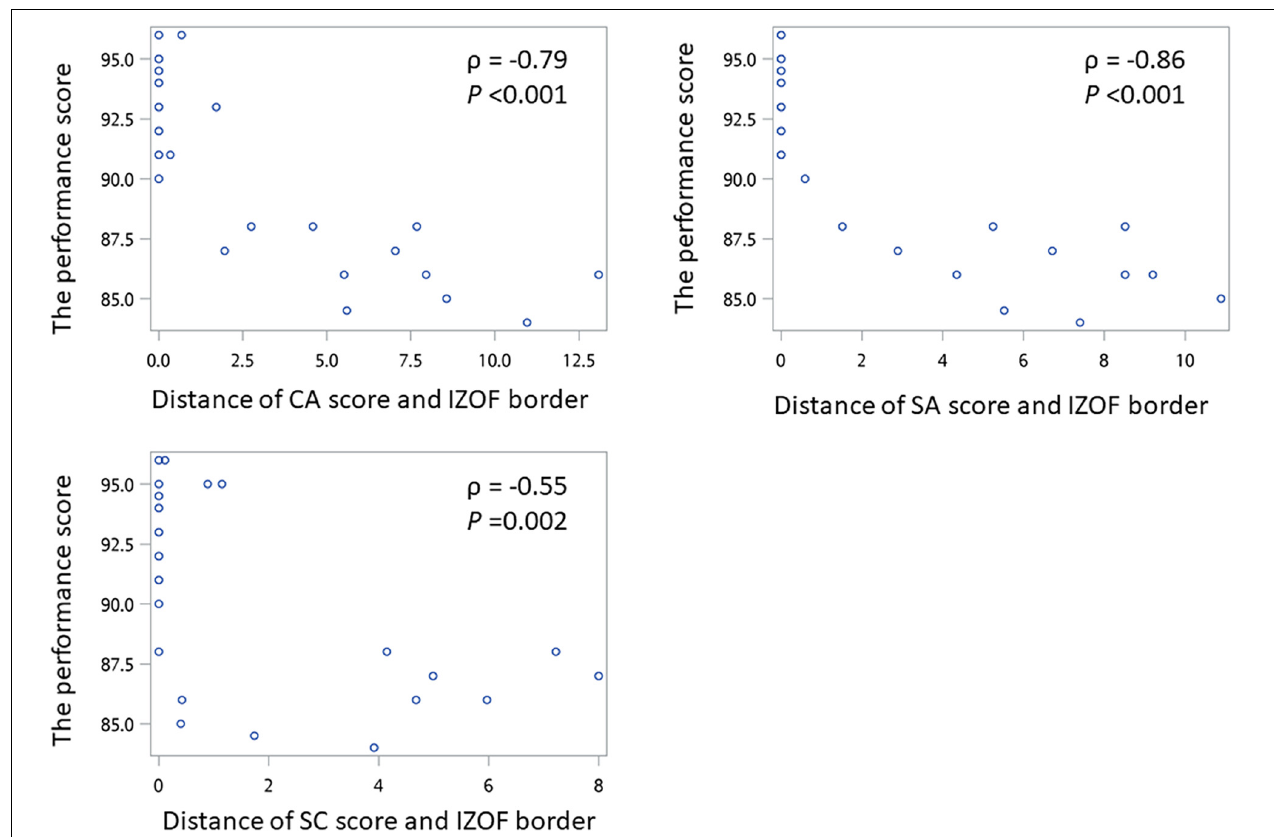
FIGURE 4 | The scatterplot of distance from closest zone border and performance